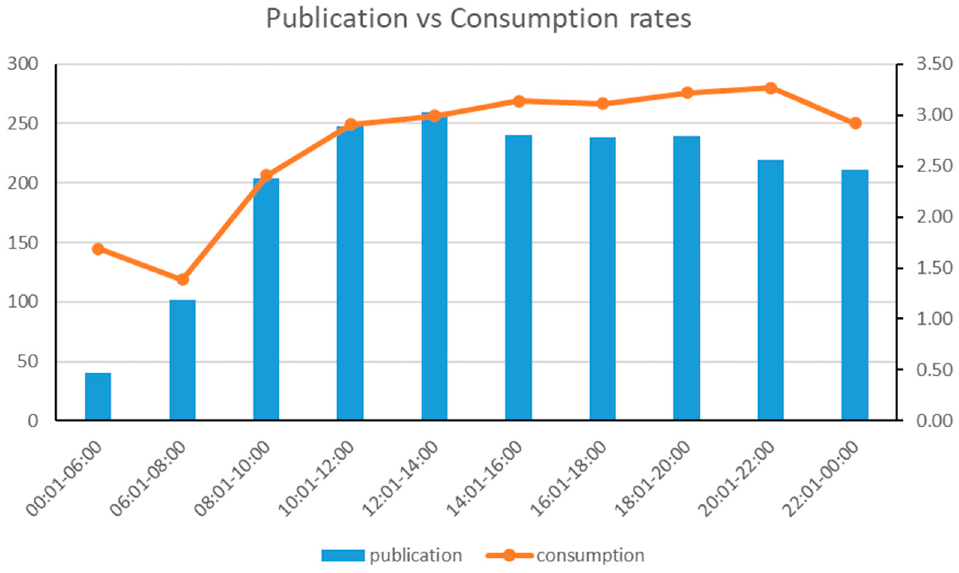
Figure 2. Comparison of the average number of published articles and reported consumption rates during different periods of the day.